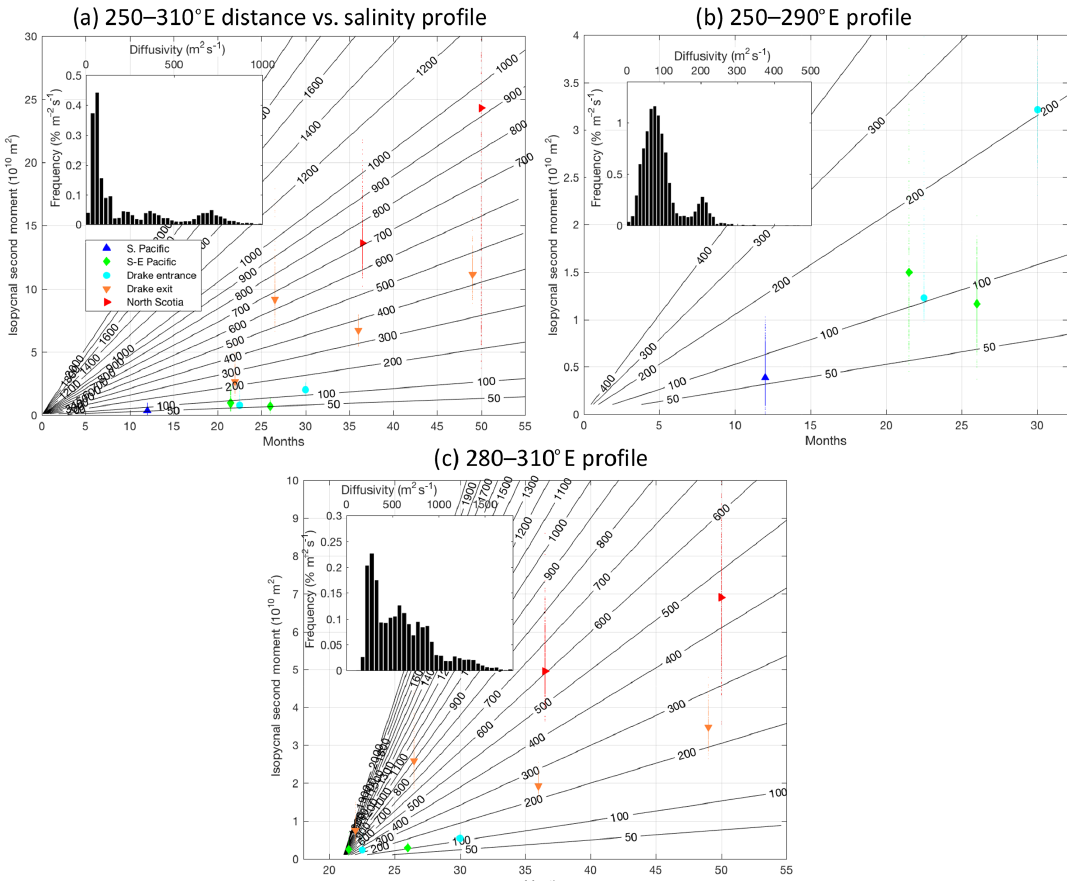
Figure 8. Isopycnal second moment of the tracer versus time since release, computed by projecting from tracer versus salinity anomaly into tracer versus distance, using a constant distance-versus-salinity profile. Panel (a) uses the profile from salinity data between 250 and 310 ◦ E, (b) between 250 and 290 ◦ E, and (c) 280 and 310 ◦ E. Only tracer data gathered between those longitudes are shown. Each small marker represents a single member of the bootstrap ensemble and the larger marker the result of using all the data. The rate of change of the second moment in time is proportional to an apparent diffusivity (Eq. 1). Contours of apparent diffusivity are shown in black. Panels (a) and (b) show the case where the growth is linear from the release date, and (c) shows an offset of 21 months. Within each panel are shown the distribution functions of diffusivity estimates. In (a) and (b) these assume constant mixing from the release date. In (c) these estimates are based on the slope between the two eastern South Pacific sections and the two Scotia Sea